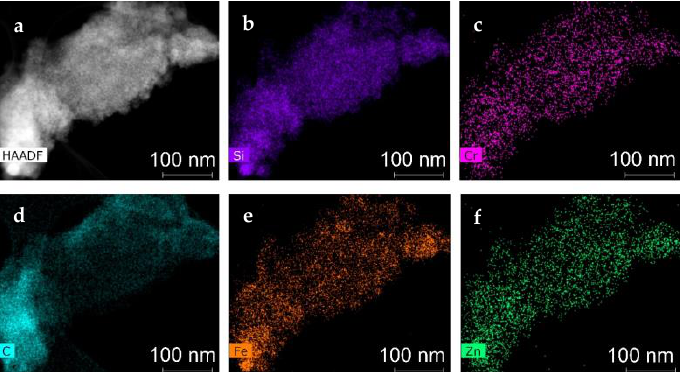
Figure 1. STEM dark field image ( a ) and EDS maps of Si ( b ), Cr ( c ), C ( d ), Fe ( e ) and Zn ( f ) of SiO 2 -Fe 3 O 4 -PPP-Cr-Zn nanocomposite.